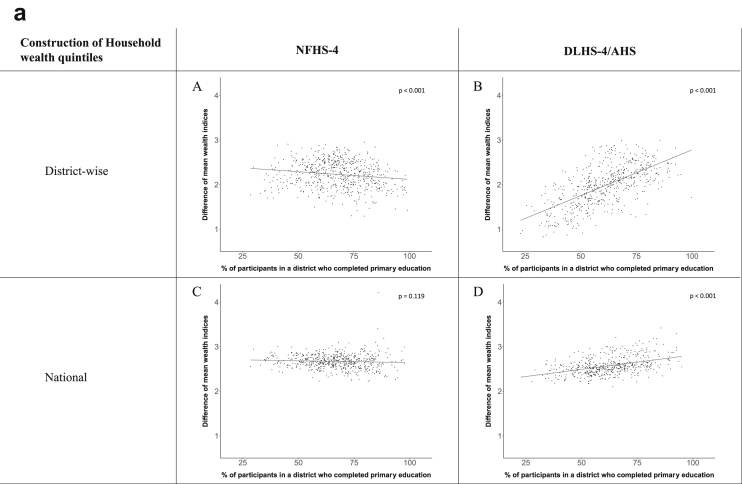
Association of a district's primary school completion rate with the difference in the continuous household wealth index between highest and lowest household wealth quintile (computed for each district). The asset score was standardized by subtracting the mean and dividing by one standard deviation. The grey line through the scatterplots has been fitted using ordinary least squares regression (with each data point in the plot having the same weight). The p-value shows whether the slope of the grey line is significantly different from zero. We excluded districts with fewer than 20 participants in the highest or lowest household wealth quintile.